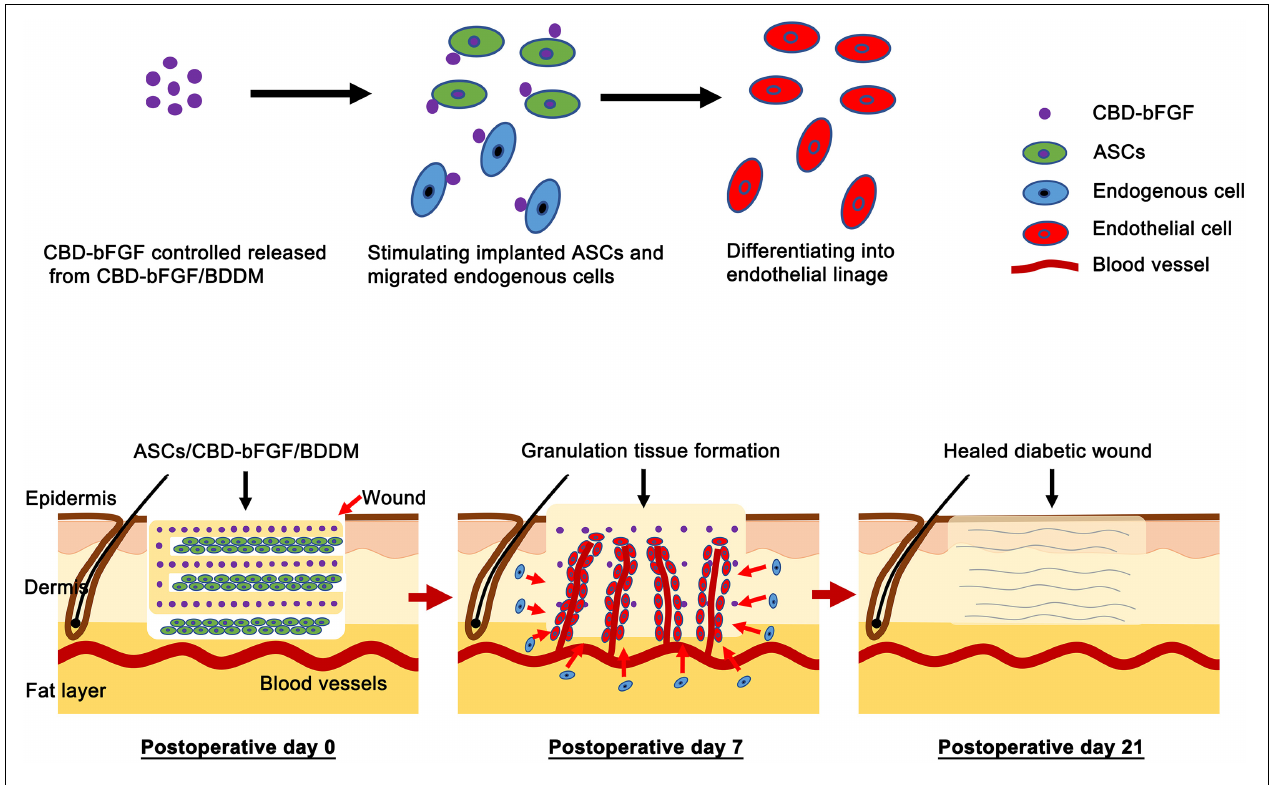
FIGURE 10 | Schematic illustrating the application of adipose-derived stromal cells (ASCs)/collagen-binding domain–basic fibroblast growth factor (CBD–bFGF)/book-shaped decellularized dermal matrix (BDDM) in diabetic wound healing and their potential mechanisms. The CBD–bFGF/BDDM releases the tethered bFGF in a controlled pattern and then stimulates the implanted ASCs, and the endogenous cells migrated into the wound site down into the endothelial lineage, thus promoting diabetic wound healing, including enhancing the angiogenesis, granulation tissue formation, collagen deposition, and